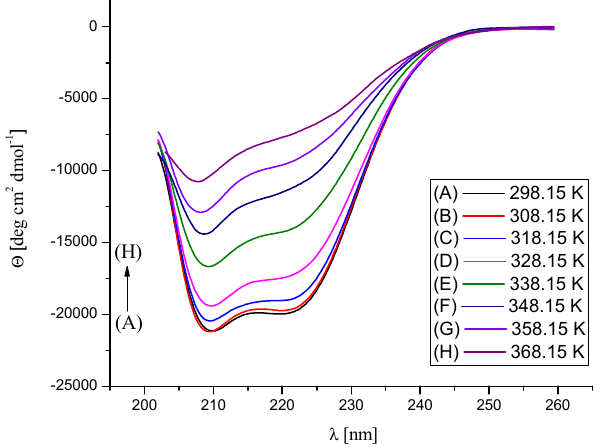
Figure 8. CD spectra of BSA in 10 mM Caco buffer at pH 7, in the temperature range 298.15–368.15 K. The concentration of BSA was maintained at 0.0015 mM.